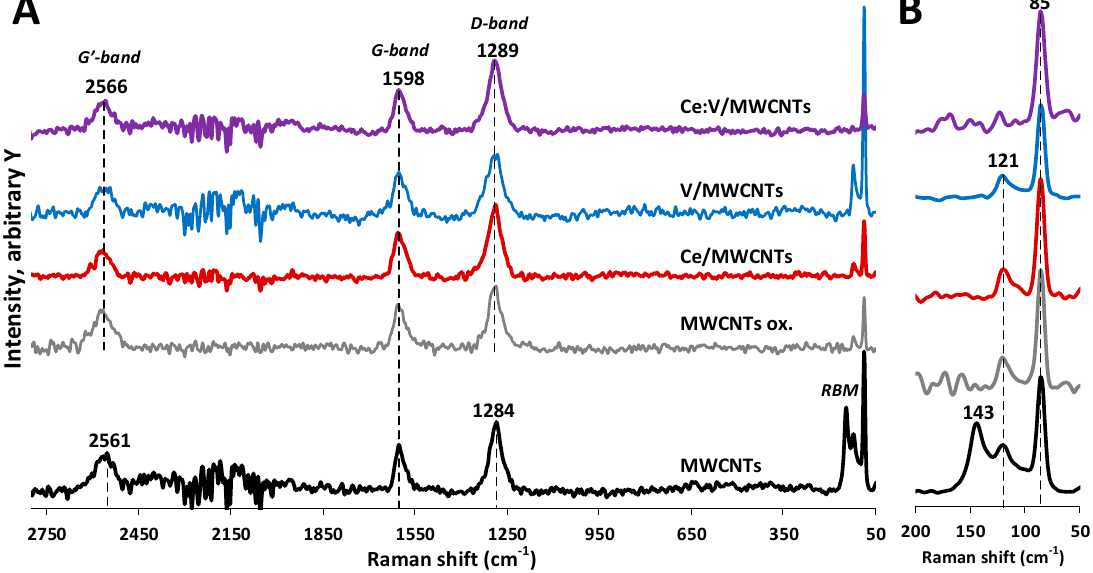
Figure 6. Raman spectra of the MWCNTs samples: ( A ) normalized to the D-band intensity in the 2750–50 cm − 1 region, ( B ) normalized to the RBM bands in the 200–50 cm − 1 region.